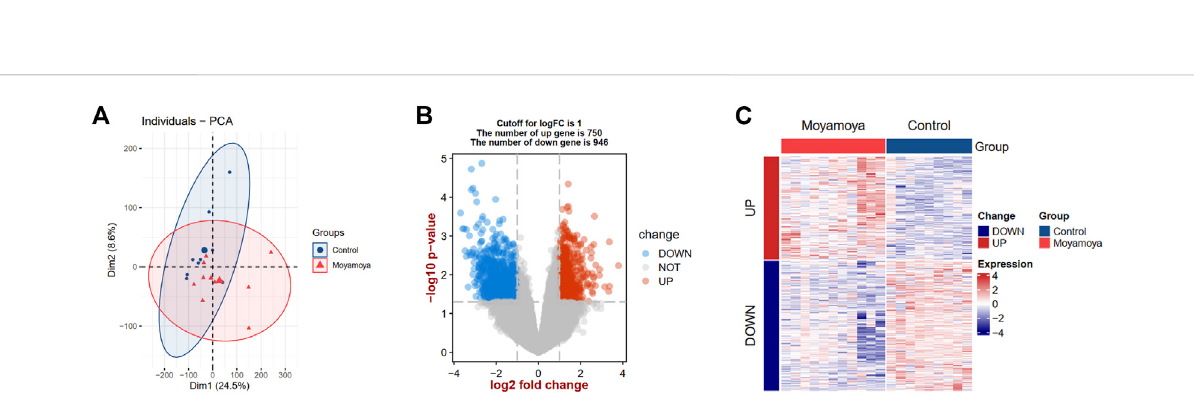
FIGURE 2 PCA and DEG analysis between MMD tissues and controls. (A) Principal component analysis between MMD tissues and controls. (B) A volcano plot shows the DEGs. Blue dots show the down-regulated genes and red dots represent the up-regulated genes. (C) A heat map shows the expression patterns of DEGs. PCA, principal component analysis; DEGs, differentially expressed genes; MMD, moyamoya